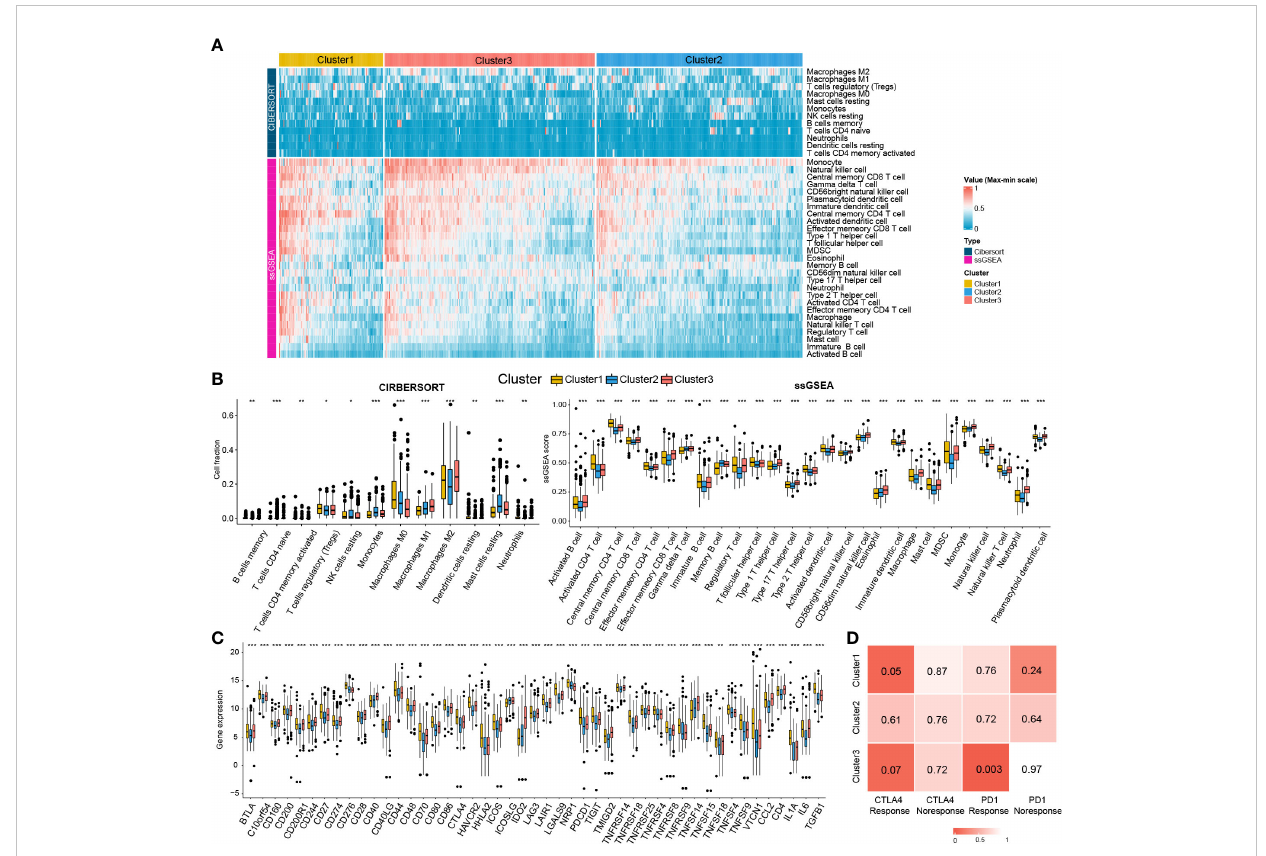
FIGURE 7 Immune cells in fi ltration landscape and immune checkpoint genes expression pro fi le of three clusters. (A) Heatmap plot shows the abundance of immune cell in fi ltration in three clusters by CIBERSORT and ssGSEA. (B) Difference of the abundance of immune cells in fi ltration among different clusters by ANOVA. (C) Difference of the level of immune checkpoint genes among different clusters by ANOVA. *P<0.05; **P<0.01; ***P<0.001. (D) The SubMap matrix shows Cluster1 may be more sensitive to the CTLA-4 inhibitor (nominal P = 0.05) and Cluster3 may be more sensitive to the PD-1 inhibitor (nominal P =